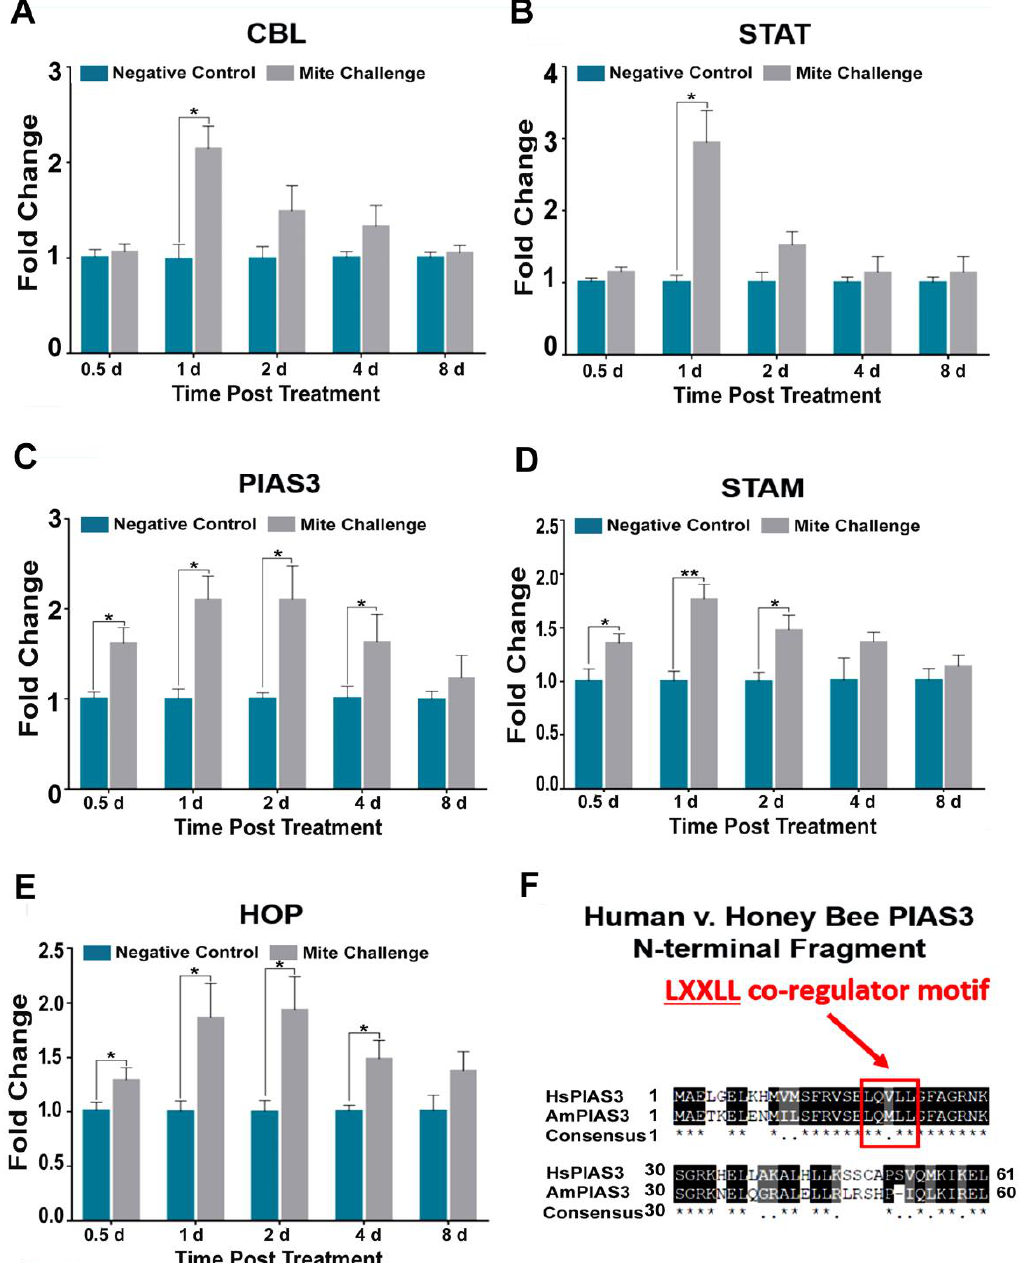
Figure 5. Fold chance of the transcription profiles for components of JAK-STAT pathway between the negative control (without Varroa challenge) and bees challenged with Varroa mites at different time points post treatment (days). ( A ) E3-ubiquitin ligase CBL, ( B ) transcription initiation factor STAT, ( C ) SUMO-ligase PIAS3, ( D ) signal adapter STAM, and ( E ) tyrosine kinase HOP demonstrating similar expression patterns to Toll pathway components of immunity (* p < 0.05, ** p < 0.01). ( F ) Multiple sequence alignment of the first 60 amino acids of human (HsPIAS3) versus honey bee (AmPIAS3). The LXXLL co-regulator motif found in humans is conserved in honey bees with a single neutral change from valine to methionine (Red).